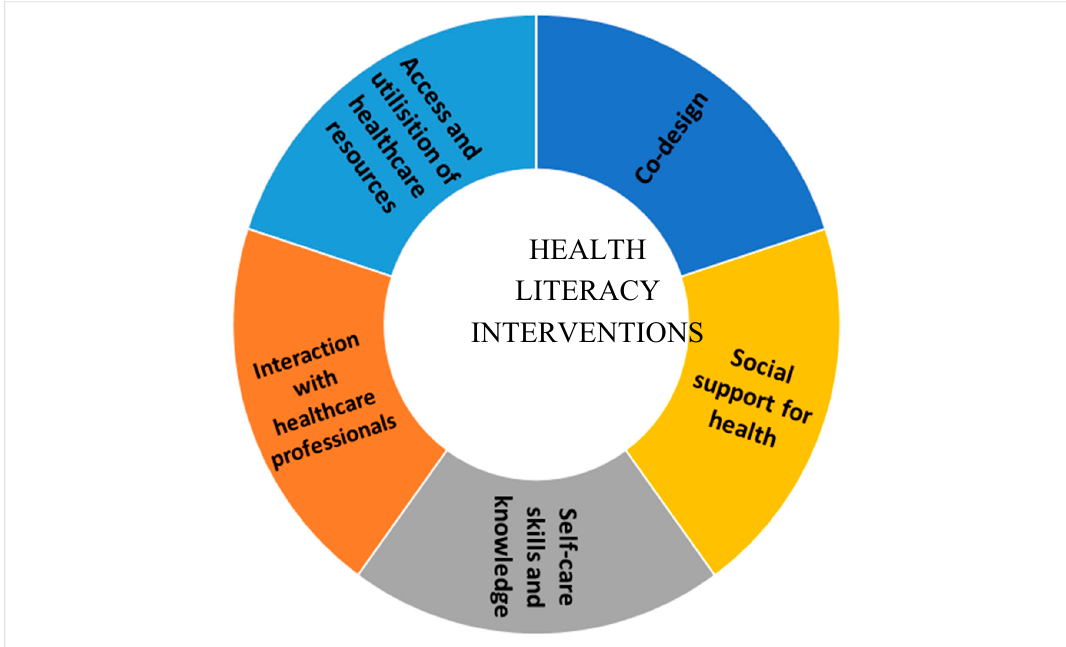
Figure 1. Health Literacy Evaluation Framework for Interventions.